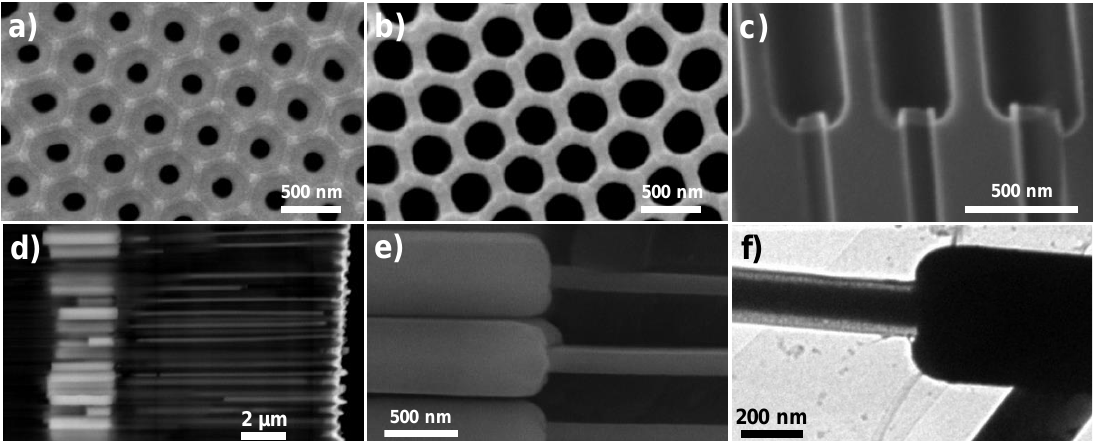
Figure 2. Morphological characterization of diameter modulated nanoporous alumina membranes and FeNi nanowires. ( a and b ) SEM images of a nanoporous alumina membrane obtained at the narrow ( a ) and wide ( b ) pore diameter surfaces. ( c ) Cross-section SEM image of the anodic alumina template showing the sharp modulation in the pore diameter of each segment, at the interface. ( d ) Cross-section SEM image of sample WM2 with diameter modulated FeNi nanowires embedded in the alumina template. ( e ) High-magnification SEM image taken at the modulation interface of the FeNi nanowires embedded into the nanoporous alumina templates. ( f ) TEM image of a single and freestanding bi-segmented FeNi nanowire, showing the sharp diameter modulation between the two nanowire segments and the thinner SiO 2 cover layer.